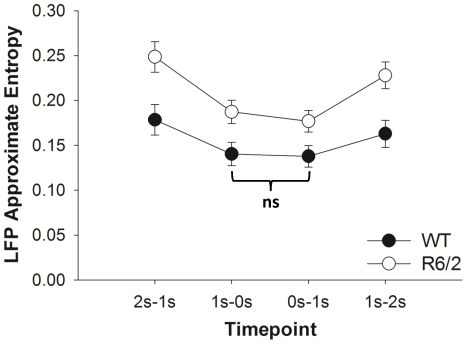
ApEn values for the LFP dynamics around the choice points, illustrating the significant Time×Group interaction.All the Bonferroni-corrected pairwise comparisons were significant, with the exception of the comparison marked ns for not significant. Both the main effects of Group and Time were significant. Data are averaged across all choice-point crossings and animals within each group; error bars reflect one standard error of the mean.